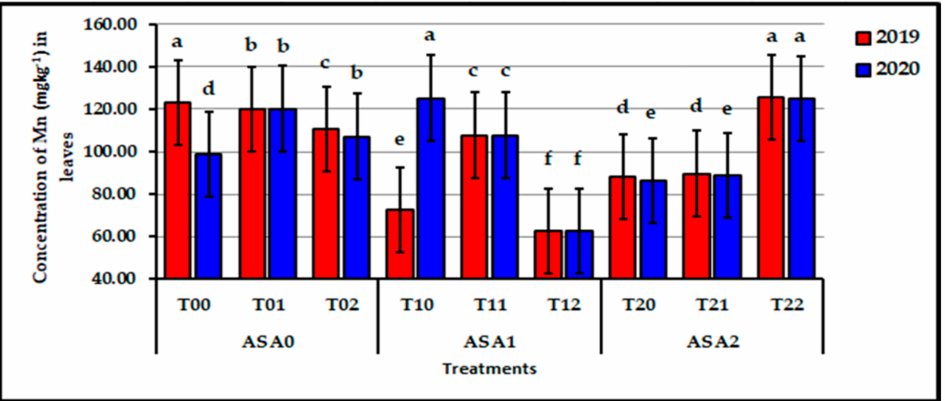
Figure 6. Influence of interaction between zinc oxide nanoparticles and ascorbic acid on leaf Mn content of stressed sweet potato plants in 2019 and 2020 seasons. Bars with a different letter indicate significant difference between treatments at p ≤ 0.05.